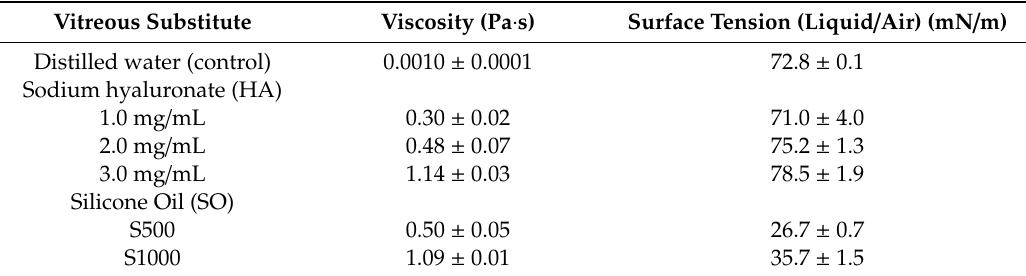
Figure 4. Viscosity of vitreous substitutes with an increasing shear rate (0–200 s − 1 ) at 25 °C. ( A ) HA (1.0–3.0 mg/mL) exhibited a non-Newtonian and viscoelastic behavior and ( B ) SO (S500–S1000) exhibited a Newtonian fluid profile. The dynamic viscosity of water is reported on both graphs for comparison. Table 1. Summary of viscosity and surface tension measurements of vitreous substitutes.